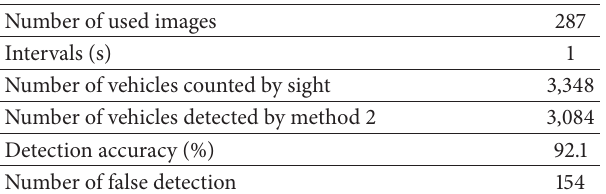
Table 2: Vehicle detection results using three video clips taken in